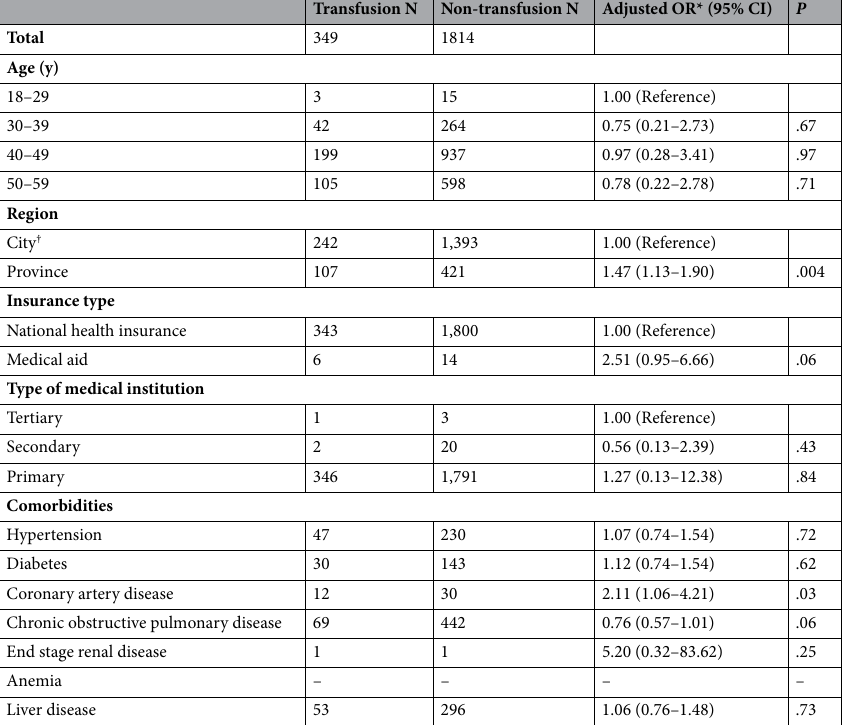
Table 4. Risk factors for transfusion in immediate autologous breast reconstruction patients. OR odds ratio, CI confidence interval. *Estimated by logistic regression adjusted for age, region, insurance type, medical institution type, and comorbidities (including hypertension, diabetes mellites, coronary artery disease, chronic obstructive pulmonary disease, end-stage renal disease, anemia, and liver disease). † Seoul, Busan, Incheon, Daegu, Ulsan, Gwangju, and